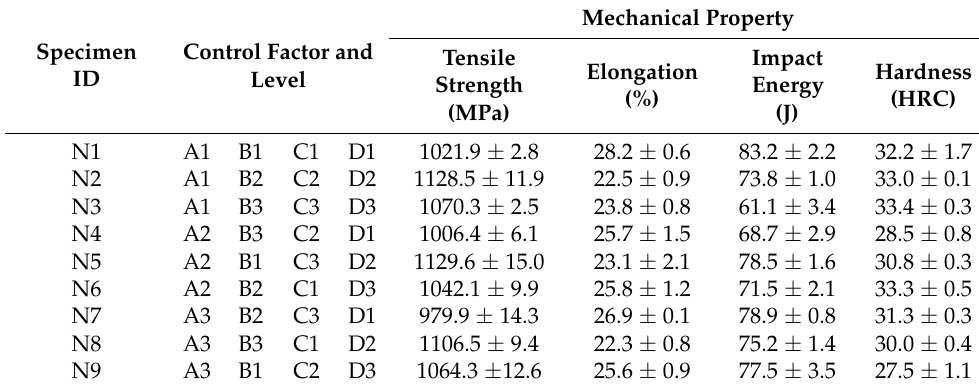
Table 2. Orthogonal array L9 (3 4 ) and mechanical properties of each trial.